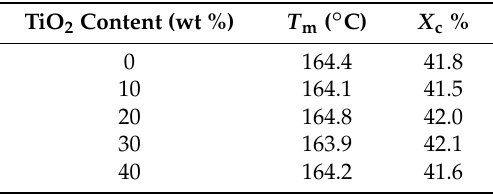
Table 1. Melting temperature ( T m ) and crystallinity ( X c ) for the polypropylene (PP) and PP/TiO 2 composite films.